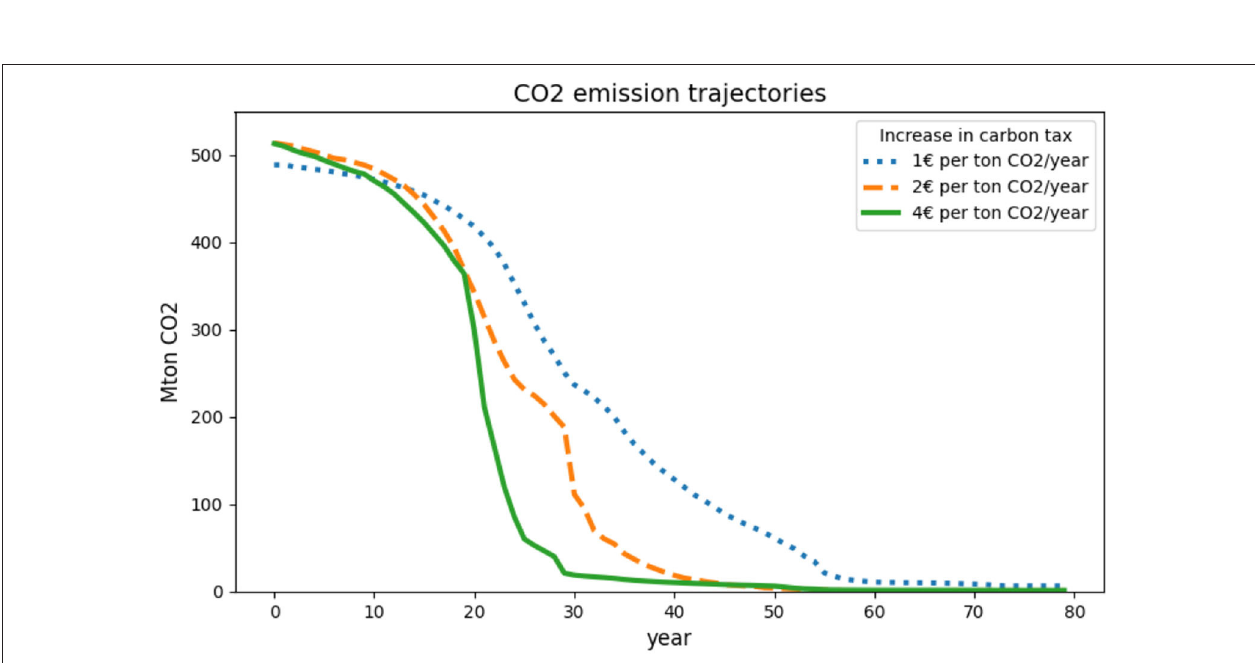
FIGURE 13 | Emission trajectories for three different carbon tax scenarios. In the base case the tax increases by 2 e ton CO 2 /year, and the sensitivity analysis tests a faster increase case (4 e ton CO 2 /year) and a slower increase case (1 e ton CO 2 /year).